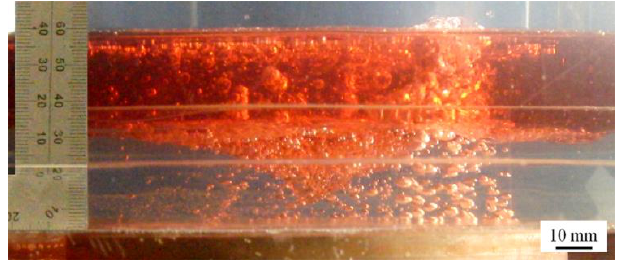
Figure 6. Behavior of foam slag beneath the slag layer under the slag thickness of 24 mm.